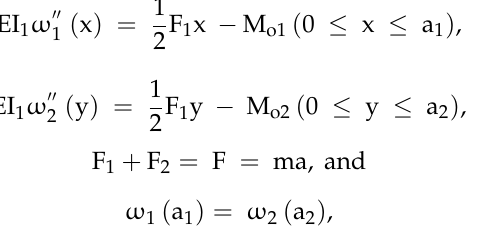
Figure 1. Diagram of the design structure.